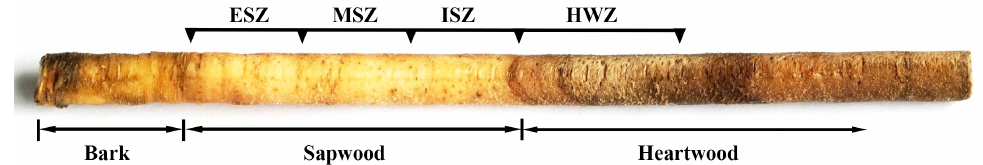
Figure 1. One of the teak wood core samples. Heartwood zone (HWZ), interior sapwood zone (ISZ), middle sapwood zone (MSZ), exterior sapwood zone (ESZ).